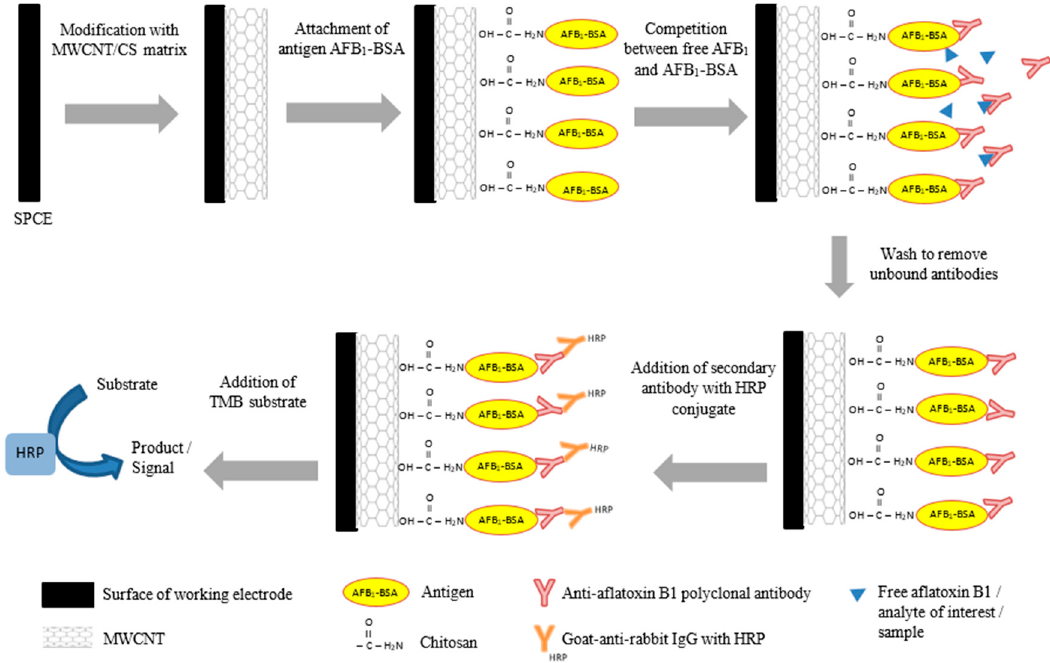
Figure 1. Fabrication of the electrochemical immunosensor by immobilization of the optimized indirect competitive enzyme-linked immunosorbent assay (ELISA) onto the modified electrode (multiwalled-carbon nanotubes/chitosan/screen-printed carbon electrode, MWCNTs/CS/SPCE).